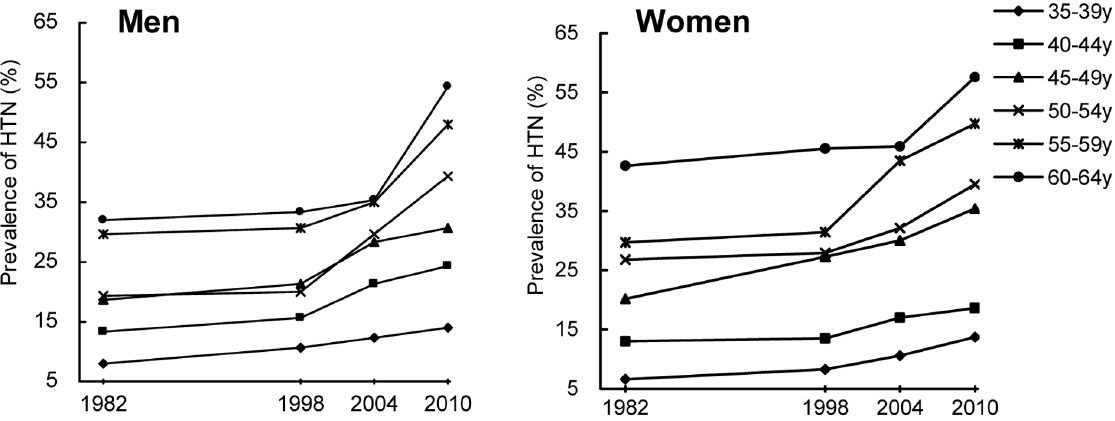
Figure 2. Trends in prevalence of HTN among adults in different sex and age group, 1982 to 2010. doi:10.1371/journal.pone.0061779.g002 PLOS ONE |